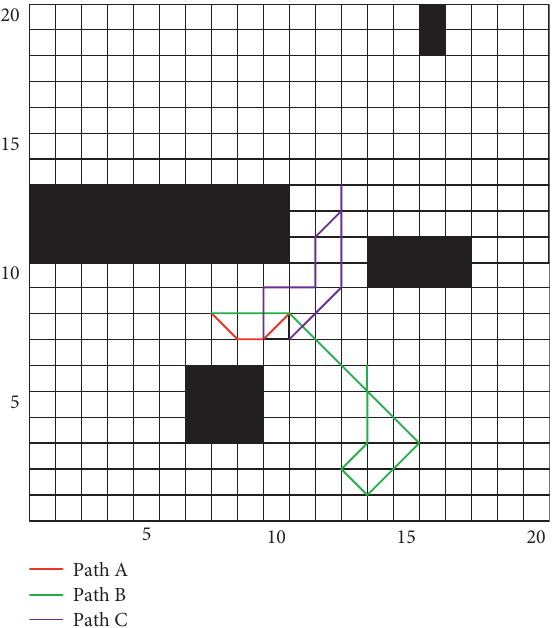
Figure 3: Algorithm